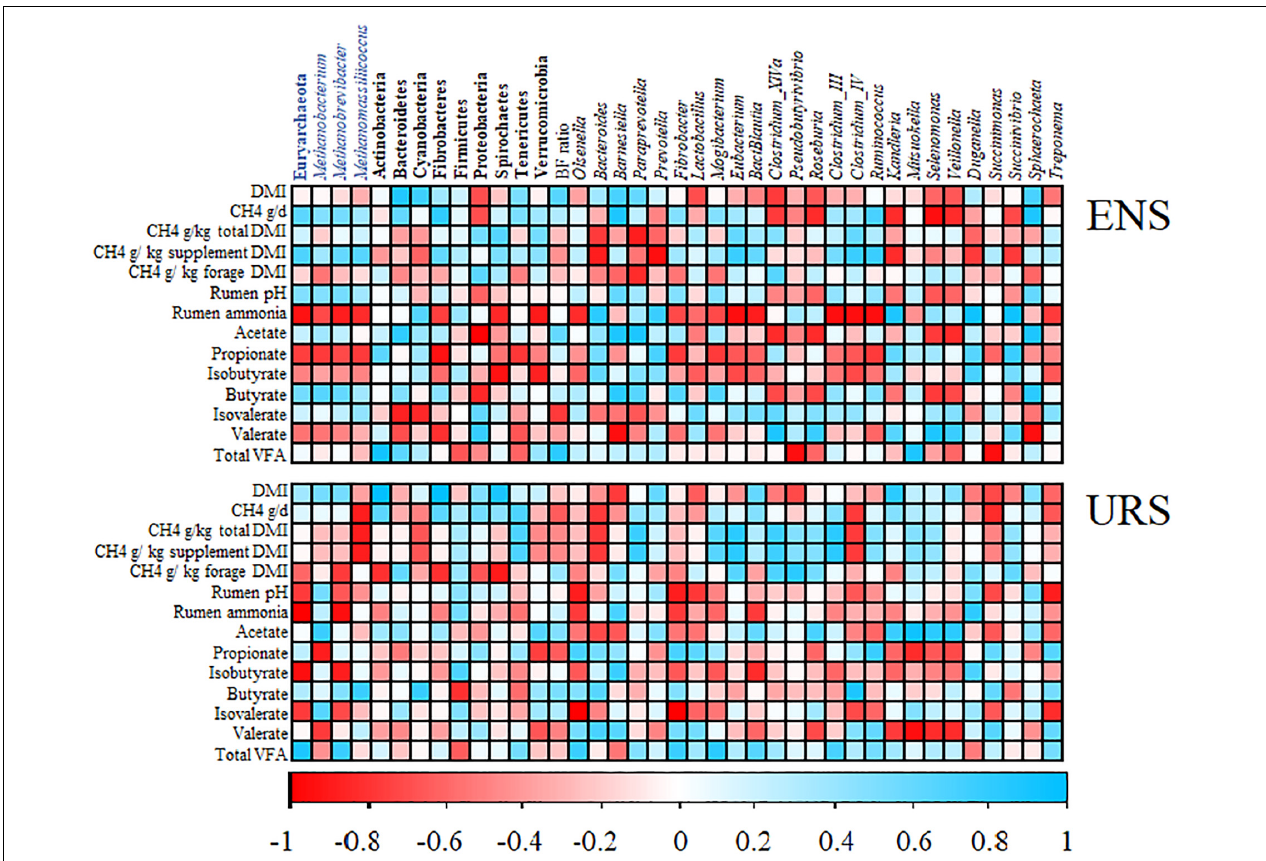
FIGURE 3 | Correlation analysis between dry matter intake, methane emissions, rumen fermentation parameters and relative abundances of ruminal microbial taxa in encapsulate nitrate supplementation (ENS) and urea supplementation (URS) groups. Spearman’s correlation values for phylum/genera across all samples was performed and only significant correlations ( P < 0.10) for at least one of the analyzed variables are shown. Names in blue and black indicate archaeal and bacteria taxa, respectively. Names in bold and italics indicate phylum and genera level, respectively. CH 4 , methane emissions; DMI, dry matter intake expresses as kg per day; VFA, volatile fatty